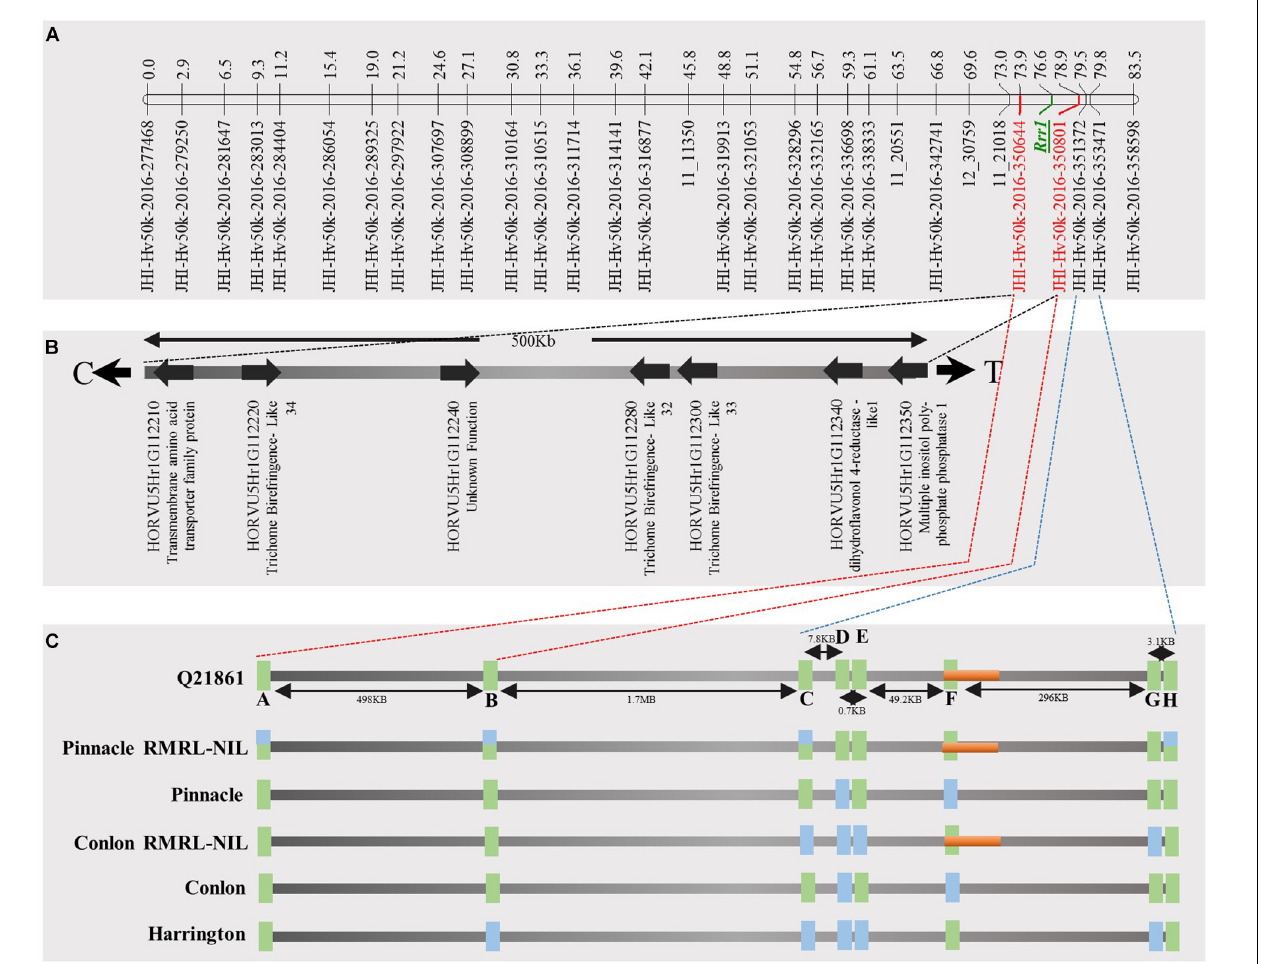
FIGURE 4 | Genetic marker saturation of barley chromosome 5H using barley 50K iSelect SNP array markers and identification of candidate genes for Rrr1 . (A) The recombination frequency of 77 Q21861/Pinnacle RMRL-NIL derived RILs was used to compute genetic map distance between 84 non-co-segregating genetic markers and Rrr1 phenotypic markers using a Kosambi mapping function in MapDisto v.1.7.7.7. The genetic map distance was used to draw a linkage map in software MapChart v2.32. Rrr1 was delimited to a genetic distance of ∼ 5.01 cM between flanking markers JHI-Hv50K-2016-350644 and JHI-Hv50K-2016-350801. (B) The physical position of the genetic markers flanking Rrr1 was used to identify seven high-confidence annotate genes from IBSC RefSeq v1.0 of barley cv. Morex genome (http://webblast.ipk-gatersleben.de/barley_ibsc/downloads/). C and T at the end of the horizontal line indicate the direction of centromere and telomere, respectively. (C) Allele analysis of marker flanking Rrr1 (represented by red dotted lines) and RMRL (represented by blue dotted lines). 50K iSelect SNP markers are represented as A (JHI-Hv-50K-2016-350644), B (JHI-Hv-50K-2016-350801), C (JHI-Hv-50K-2016-351372), D (JHI-Hv-50K-2016-351438), E (JHI-Hv-50K-2016-351449), F (JHI-Hv-50K-2016-351467), G (JHI-Hv-50K-2016-351585) and H (JHI-Hv-50K-2016-351627). The green bars represent a SNP marker with a Q21861 allele and blue color represents the alternate allele, while semi-blue-green color represents a heterozygous call for a given marker. The orange bar represents a physical region containing